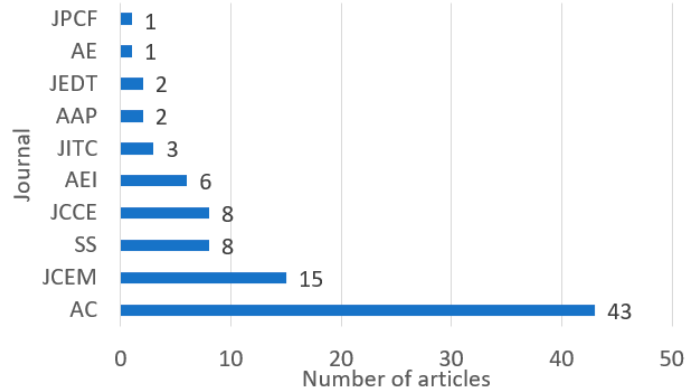
Figure 5. Number of articles published in the selected journals. Table 1. Number of articles in different research